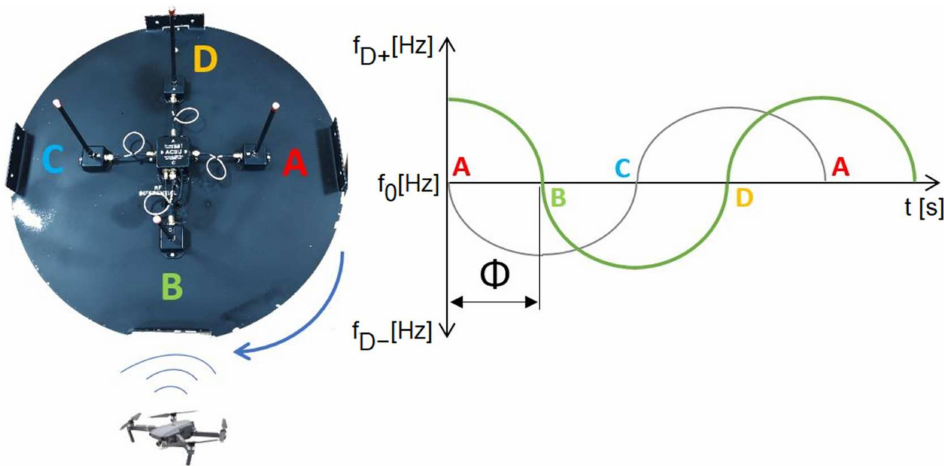
Figure 5. Graphic representation of the targeting principle using the IDVOR system for the case of targeting the next position. The θ represents phase